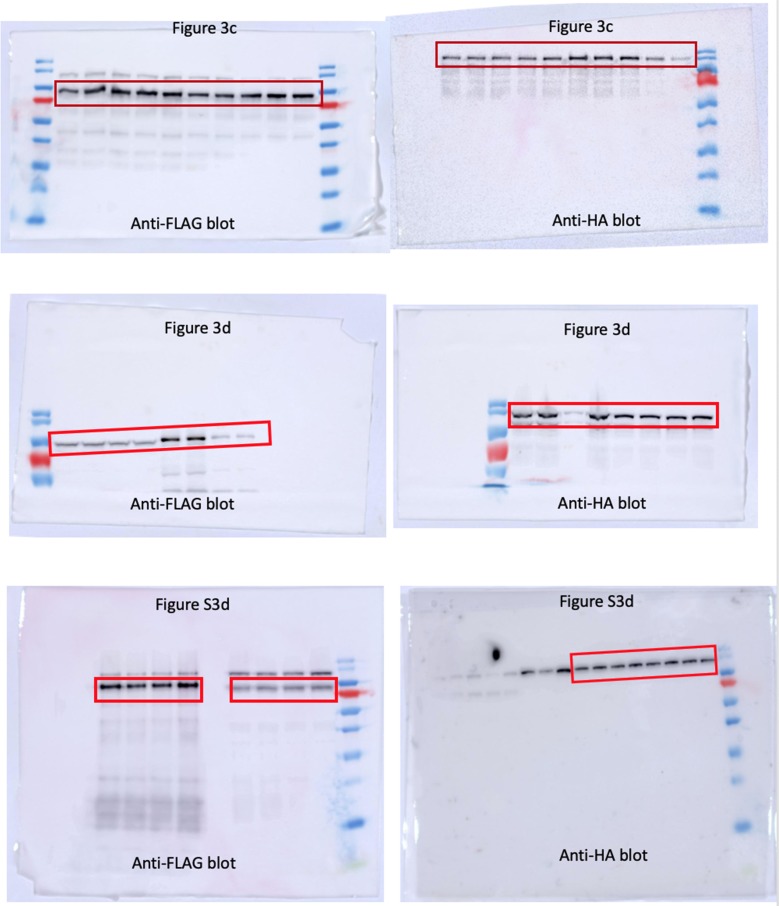
Original western blot images for Co-immunoprecipitation assays.The red boxes indicate the regions used in Figure 3c,d and Figure 3—figure supplement 2d.